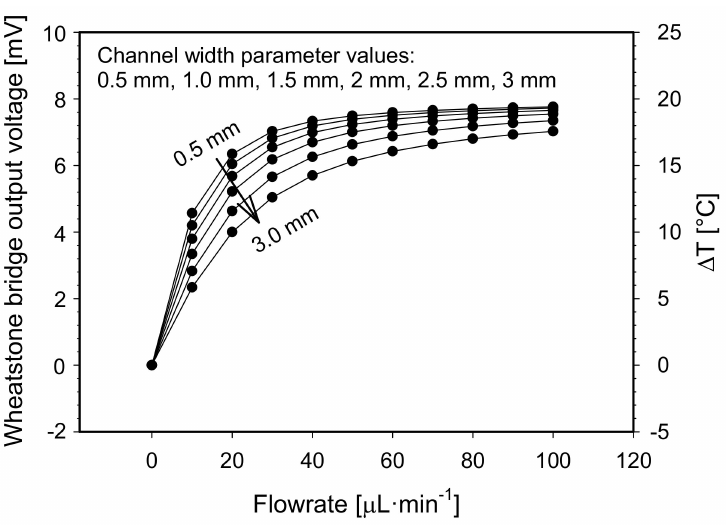
Figure 6. Constant temperature S-H-S flowmeter configuration: simulated Wheatstone bridge output voltage and differential temperature between both sensor elements vs. flowrates for preselected channel width parameter